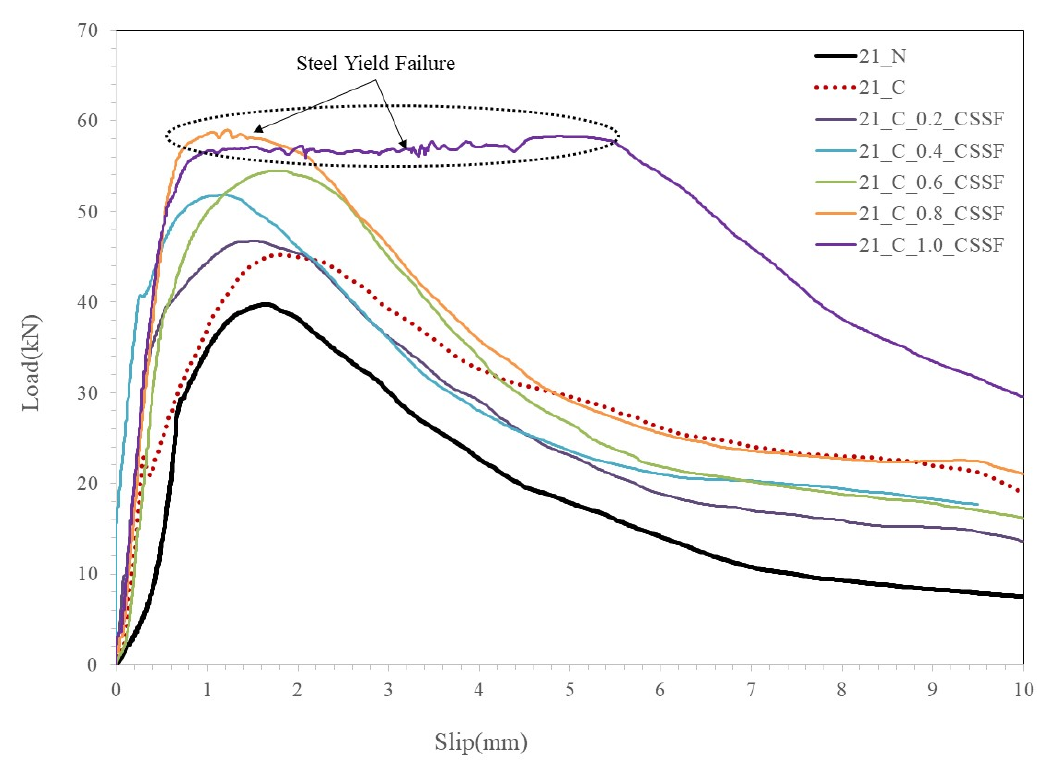
Figure 7. Load–slip curves with crimped stainless steel fiber.